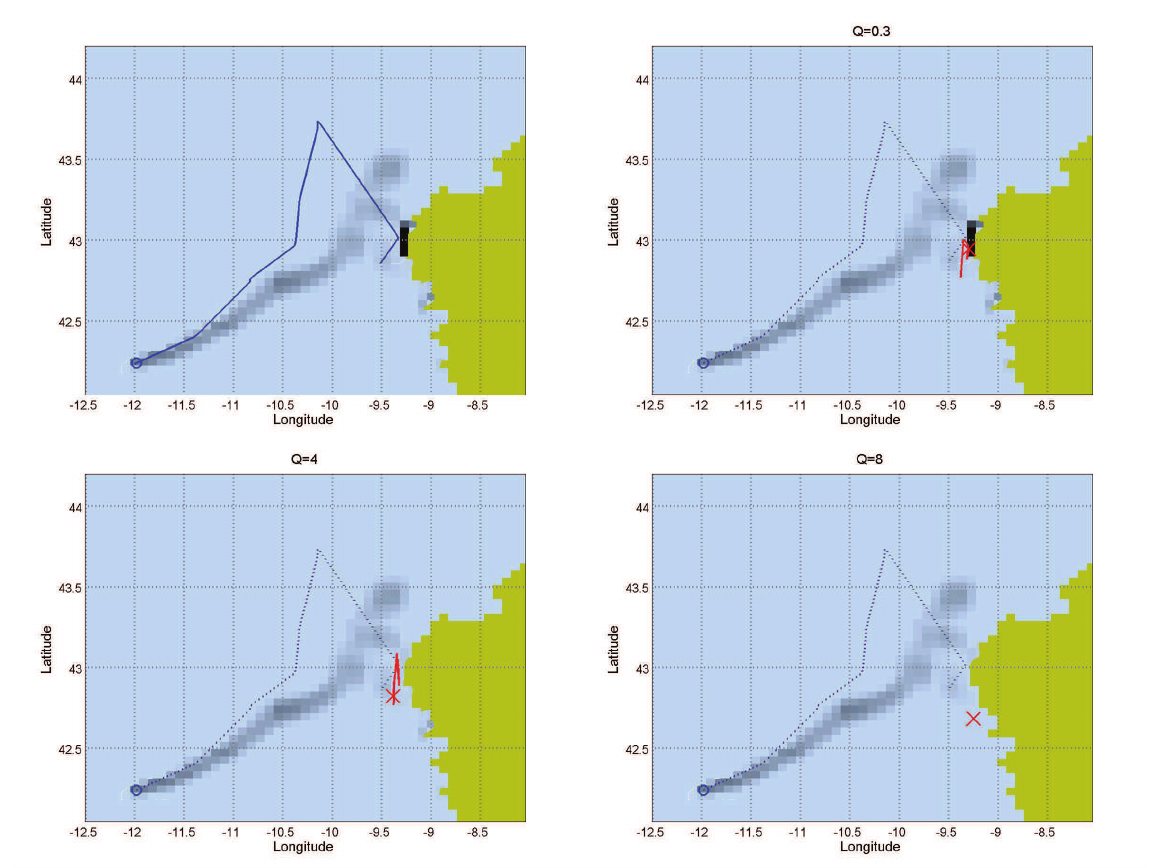
Fig. 9 Top view of the final oil concentration distribution on 19 November 2002, skimmer ship trajectory (continuous red line), final position of the skimmer ship (x) and final position of the Prestige ship (o) for the experiments: ( Top-Left ) trajectory of the Prestige ship (continuous blue line) with no pumping process, ( Top-Right ) OPT-0.3- (4), ( Bottom-Left ) OPT-4- (4) and ( Bottom Right ) OPT-8- (4). The trajectory of the Prestige ship is also presented in dotted blue